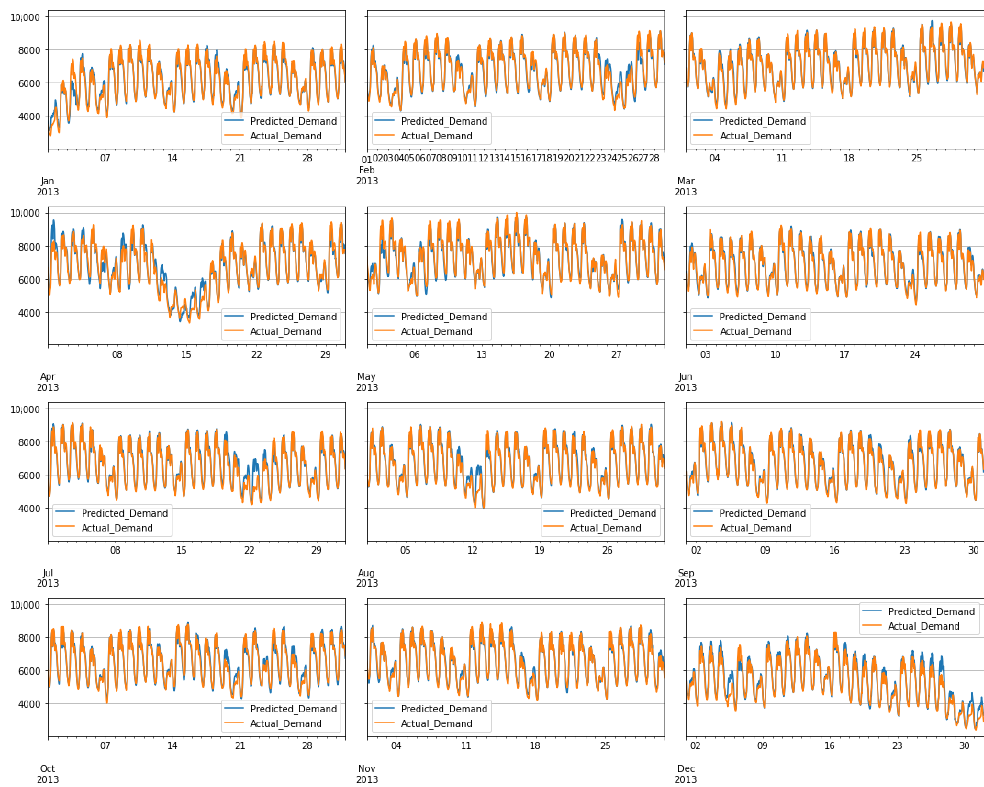
Figure A4. Forecasting performance of the VR model (Group